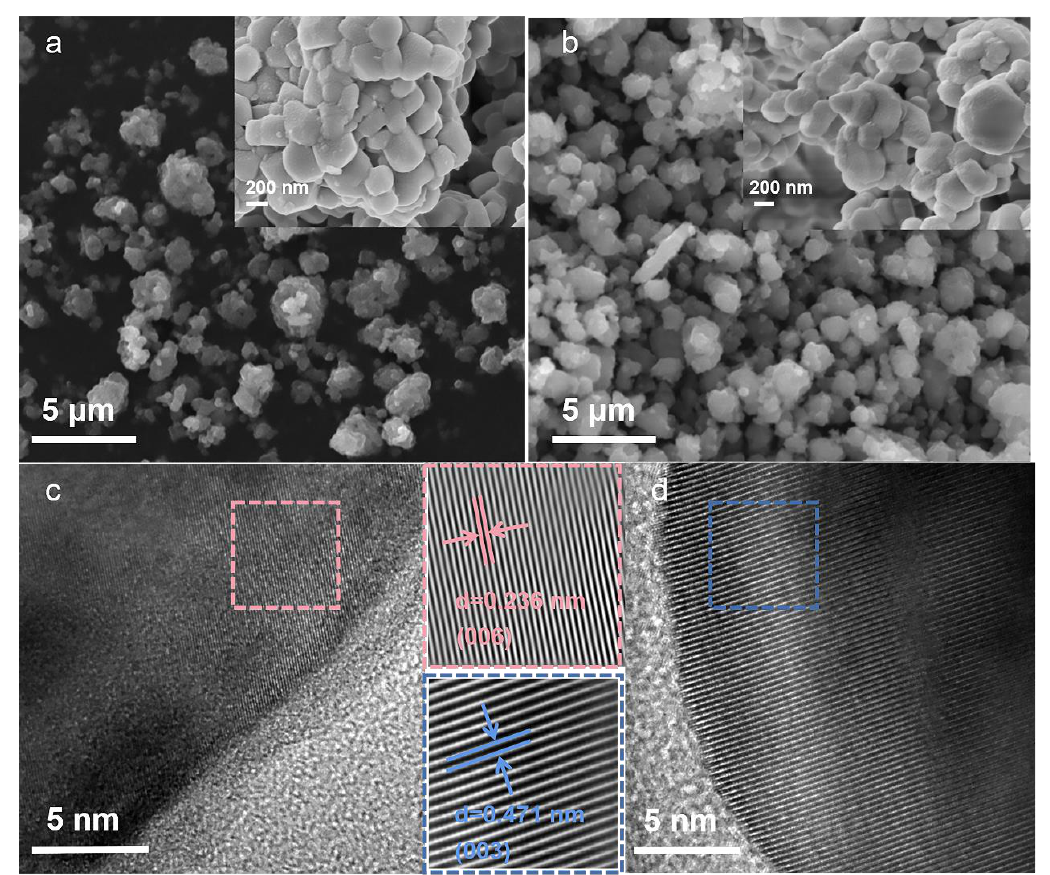
Figure 7. SEM images of ( a ) S–NCM and ( b ) C–NCM powers. TEM images of ( c ) S–NCM and ( d ) C–NCM samples.